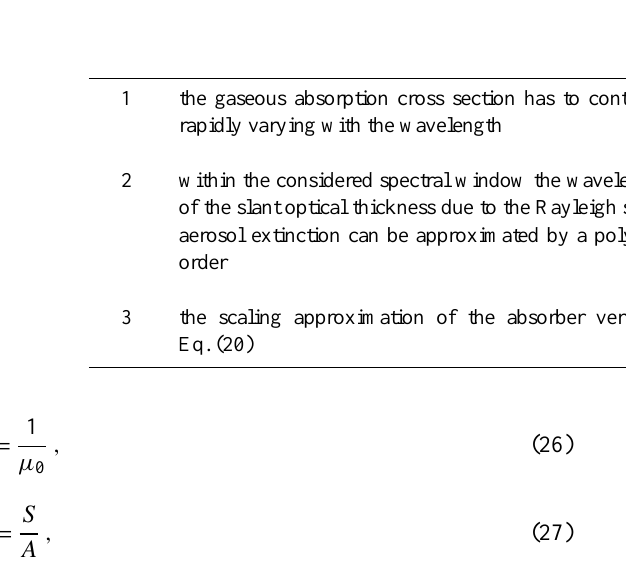
spatially constant variable cross cross section section + +